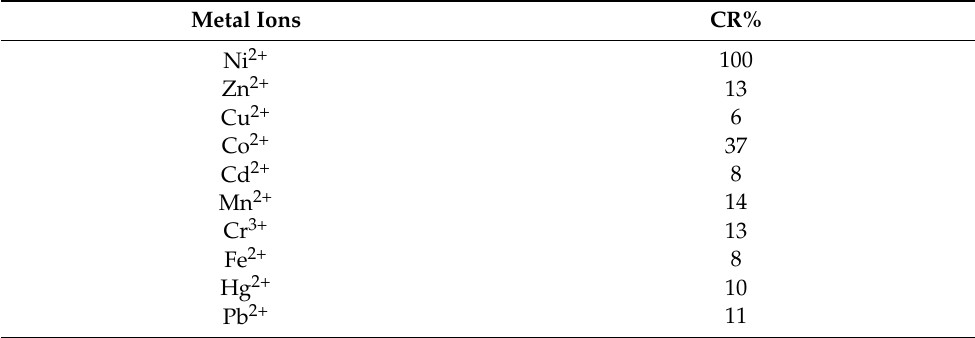
Table 2. Cross reactivity values for each metal ions calculated by Equation (2). Metal Ions